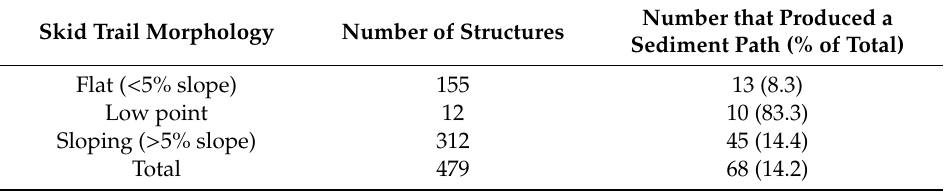
Table 2. Water control structures within experimental units of the three harvested watersheds, by the morphology of the skid trail where they were constructed. Percentage of water control structures associated with initiation of machine-caused sediment paths is also